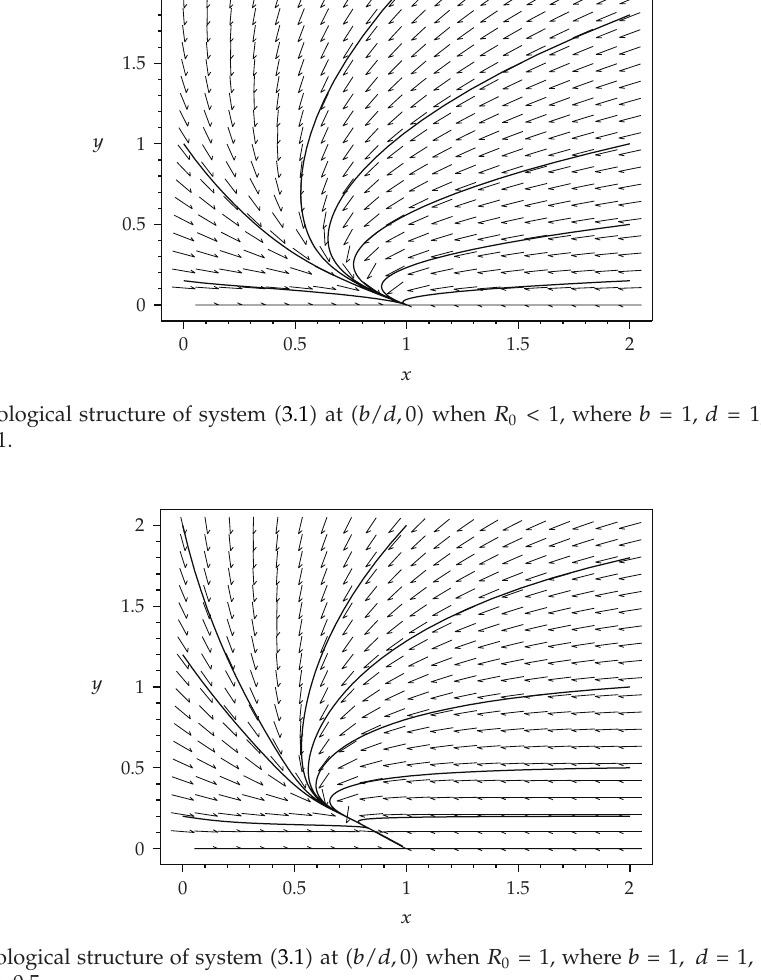
Figure 2: Topological structure of system (cid:5) 3.1 (cid:6) at (cid:5) b/d, 0 (cid:6) when R 0 (cid:7) 1, where b (cid:7) 1 , d (cid:7) 1 , k (cid:7) 1 . 5 , γ (cid:7) 0 . 5 , α (cid:7) 1 , μ (cid:7) 0 .